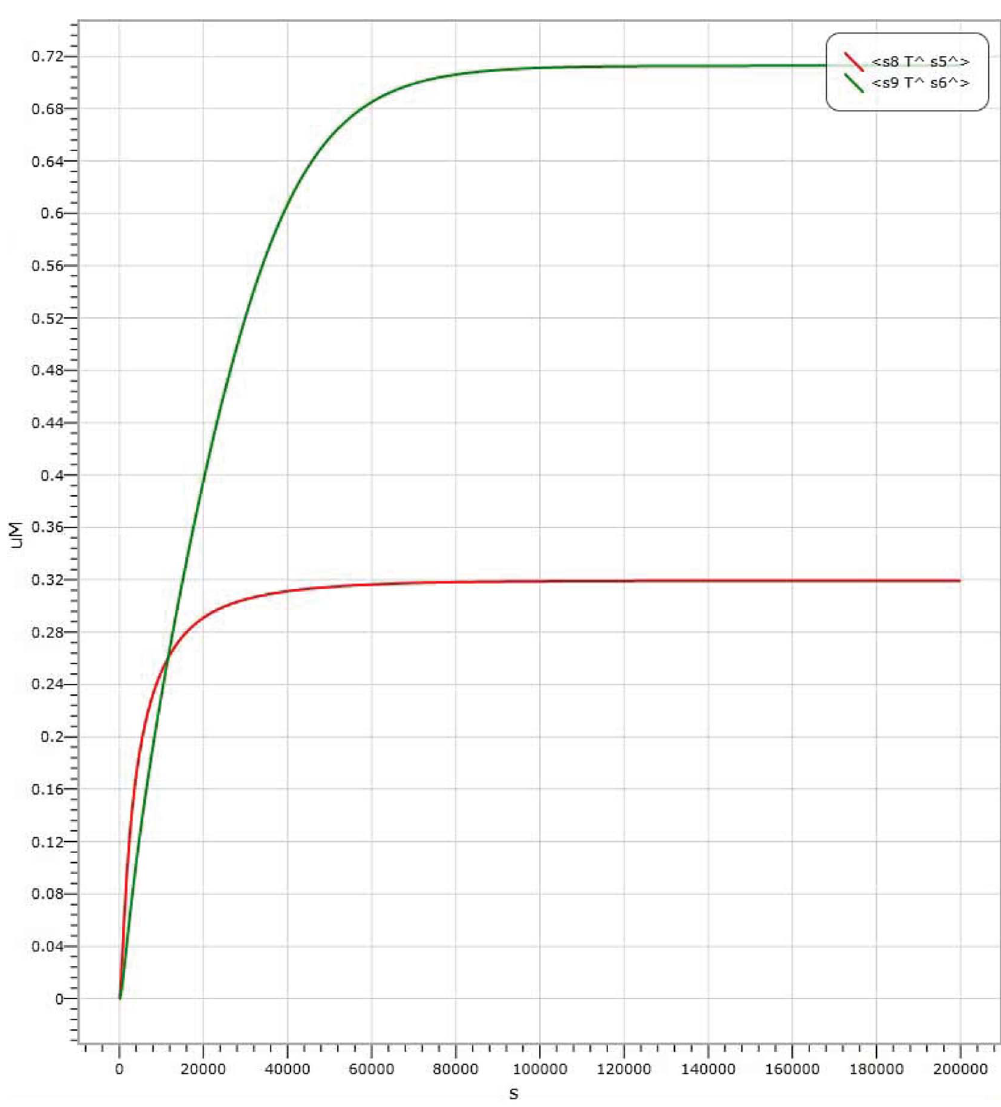
Figure 11. Visual DSD simulations of XOR logic gate with input signal ‘‘11’’.